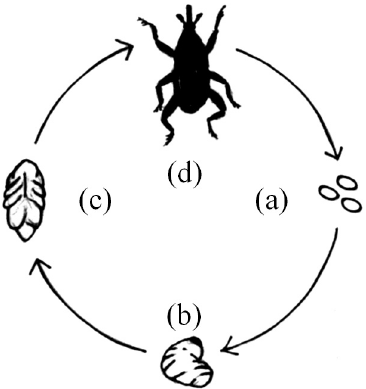
Fig. 1. The cycle of rice weevil (a) egg stage (b) pupa stage (c) larva stage (d) adult stage.